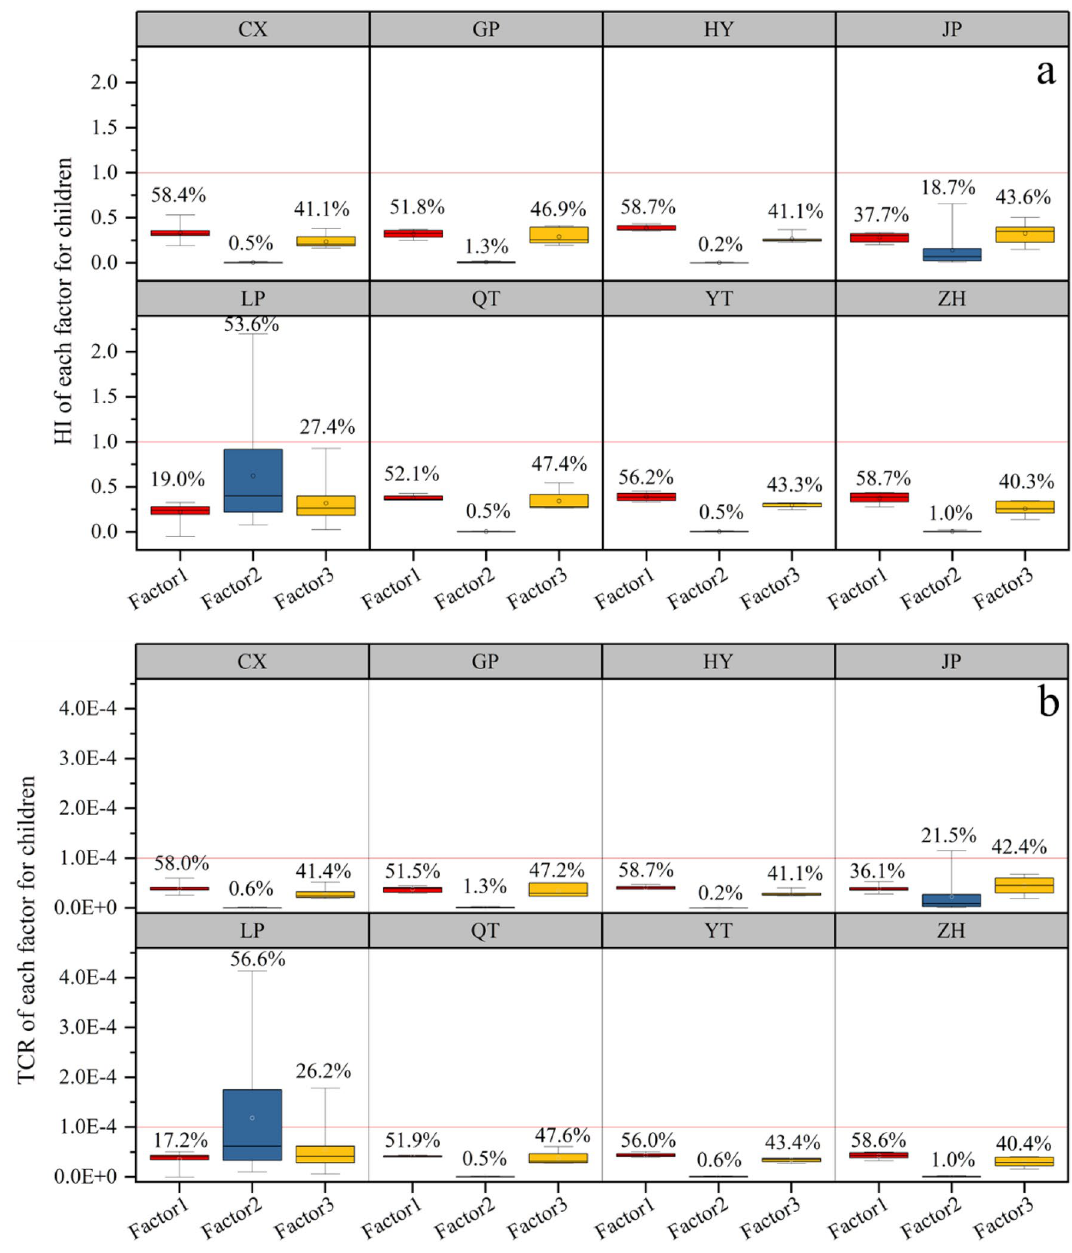
Figure 6. Contributions of various sources to HI and TCR for children. The red horizontal reference lines represent the corresponding threshold of HI (1) and TCR (1.0 × 10 –4 ). Boxes represent the interquartile range (i.e., 25th and 75th percentiles), the hollow circles represent the average values, and the whiskers represent the 5th and 95th